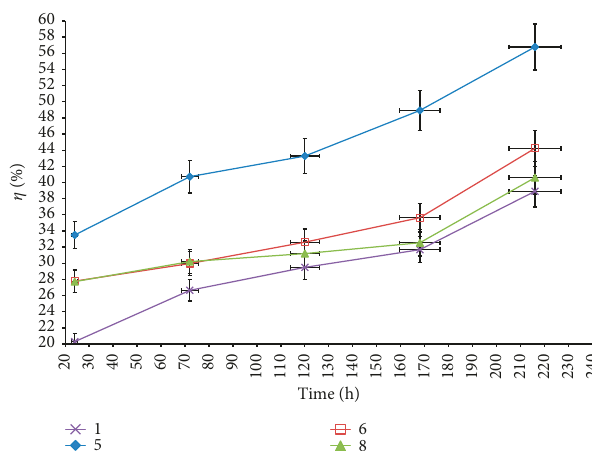
Figure 1: Relation between inhibition efficiency of aminopyridine derivatives in 6 M HCl and time at room temperature at 200ppm.